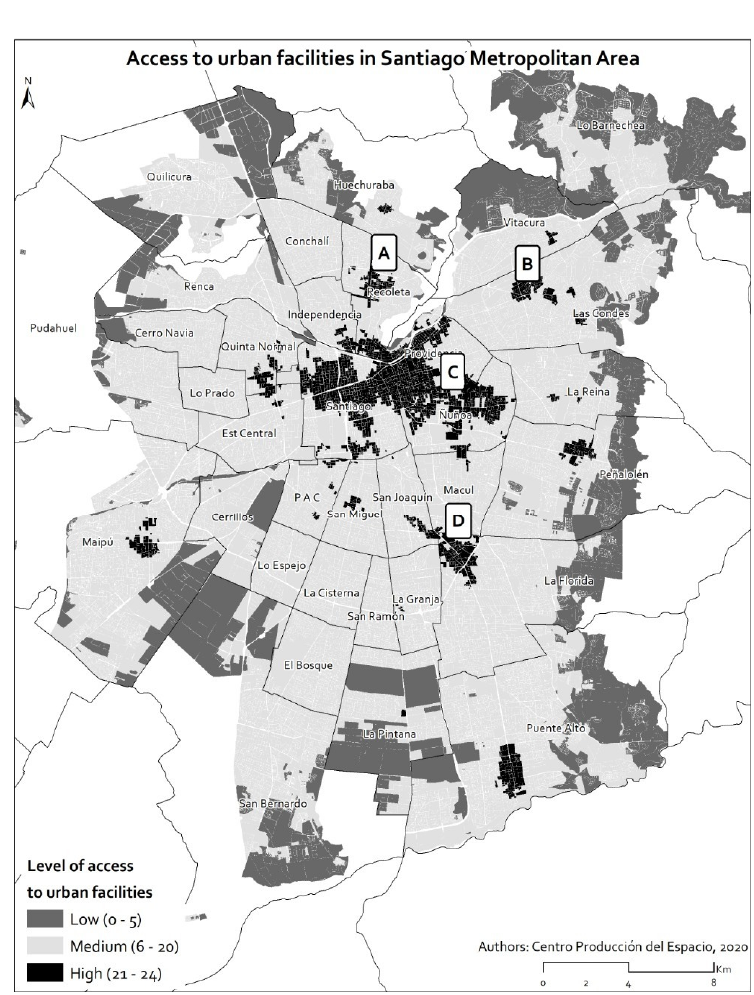
Figure A1. Location of neighborhoods with good high access to essential urban functions. ( A